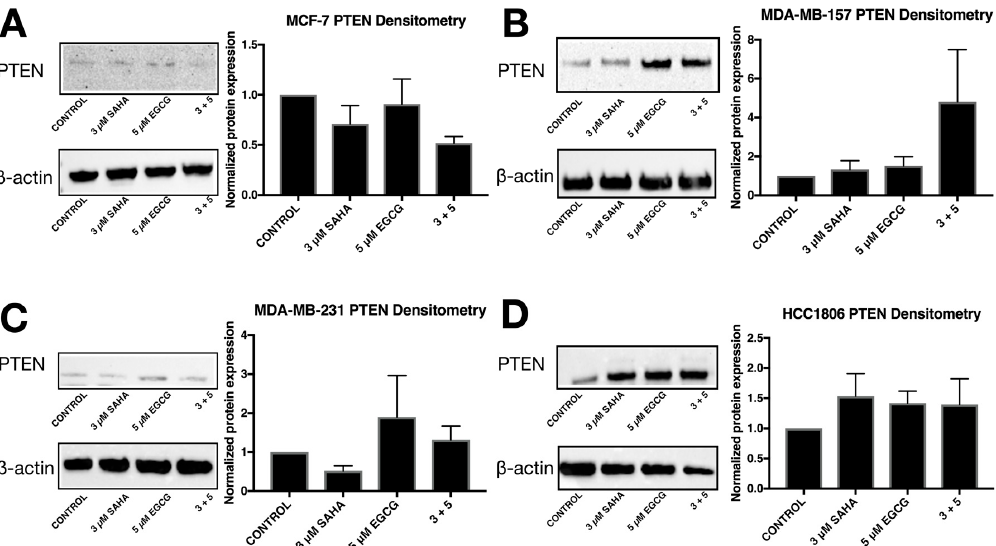
Figure 10. SAHA and EGCG induce changes in PTEN protein levels in three TNBC cell lines. ( A ) PTEN protein levels are reduced in the ER α -positive MCF-7 cells. The image is representative while quantification is indicative of the averages of three different blots. ( B – D ) The amount of PTEN protein was increased in the MDA-MB-157, MDA-MB-231, and the HCC1806 TNBC cell lines. The images are representative while quantification is indicative of the averages of three different blots. The same blots were probed multiple times, explaining the duplication of β -actin between